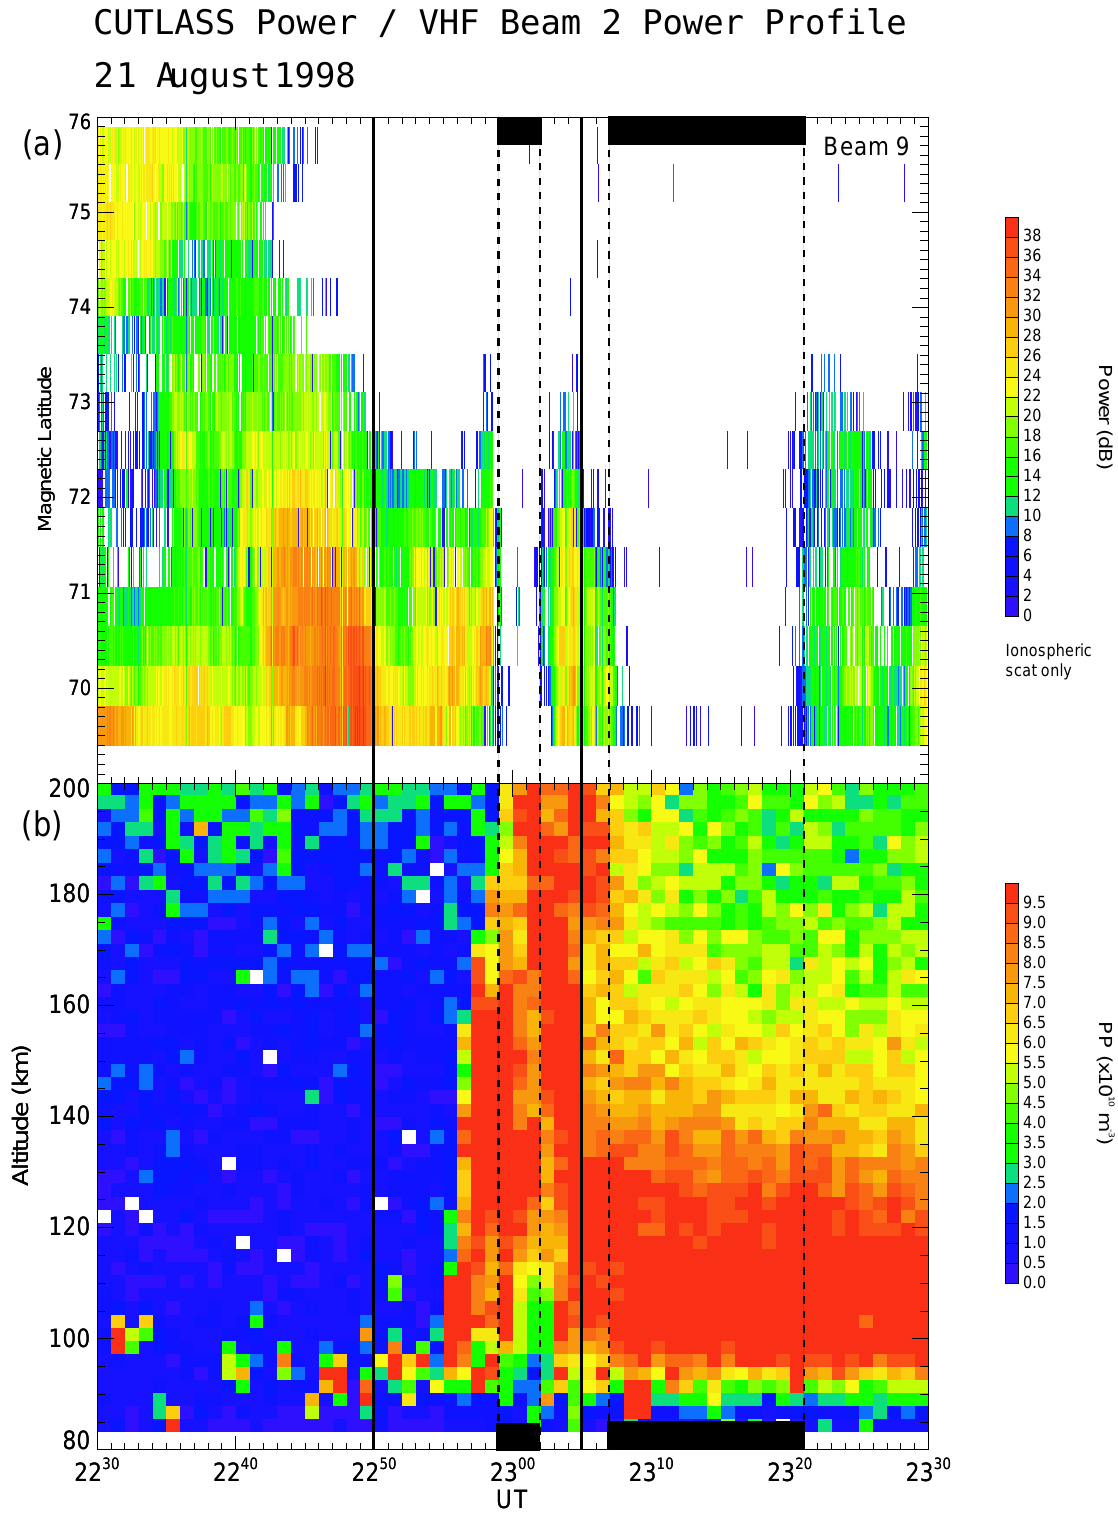
Fig. 4. (a) Hankasalmi backscatter power, as a function of magnetic latitude, for the interval 22:30–23:30UT (b) EISCAT VHF radar beam 2 power profile data, over the same time interval, as a function of altitude. Pi2 onset times are marked with vertical solid lines and the intervals of HF radar data loss with vertical dashed lines, as in Fig.